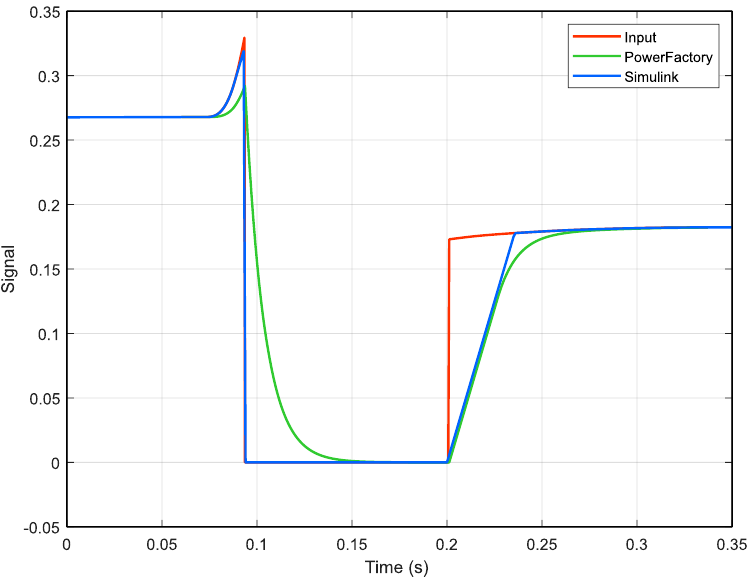
Figure 13. Rate limiters responses for the same input